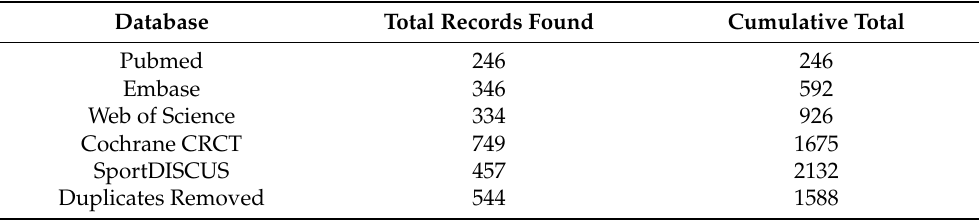
Table A1. Search results illustrating the number of studies identified from individual databases.